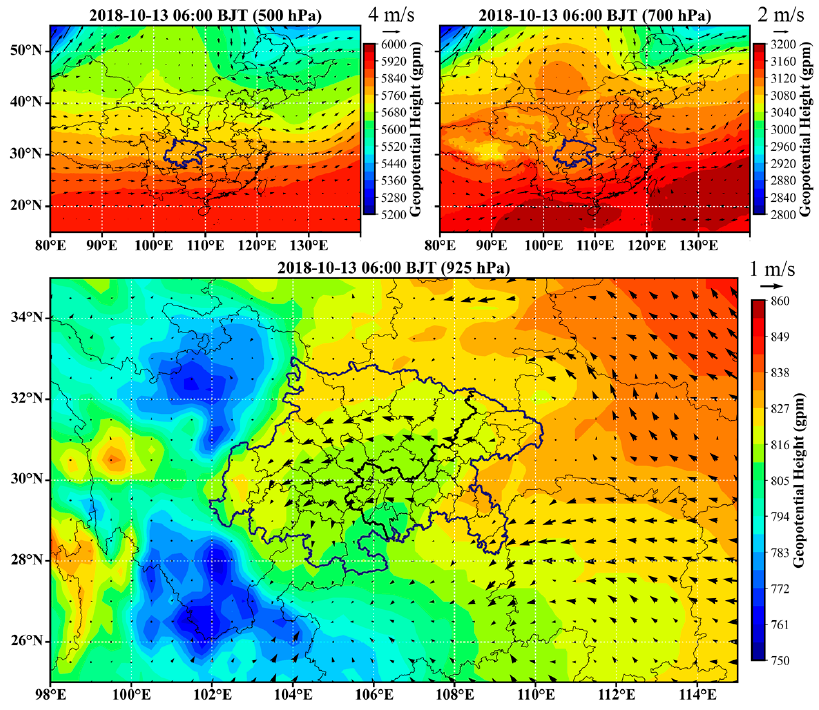
Figure 9. Typical circulation features in autumn. The arrows represent horizontal wind vectors.